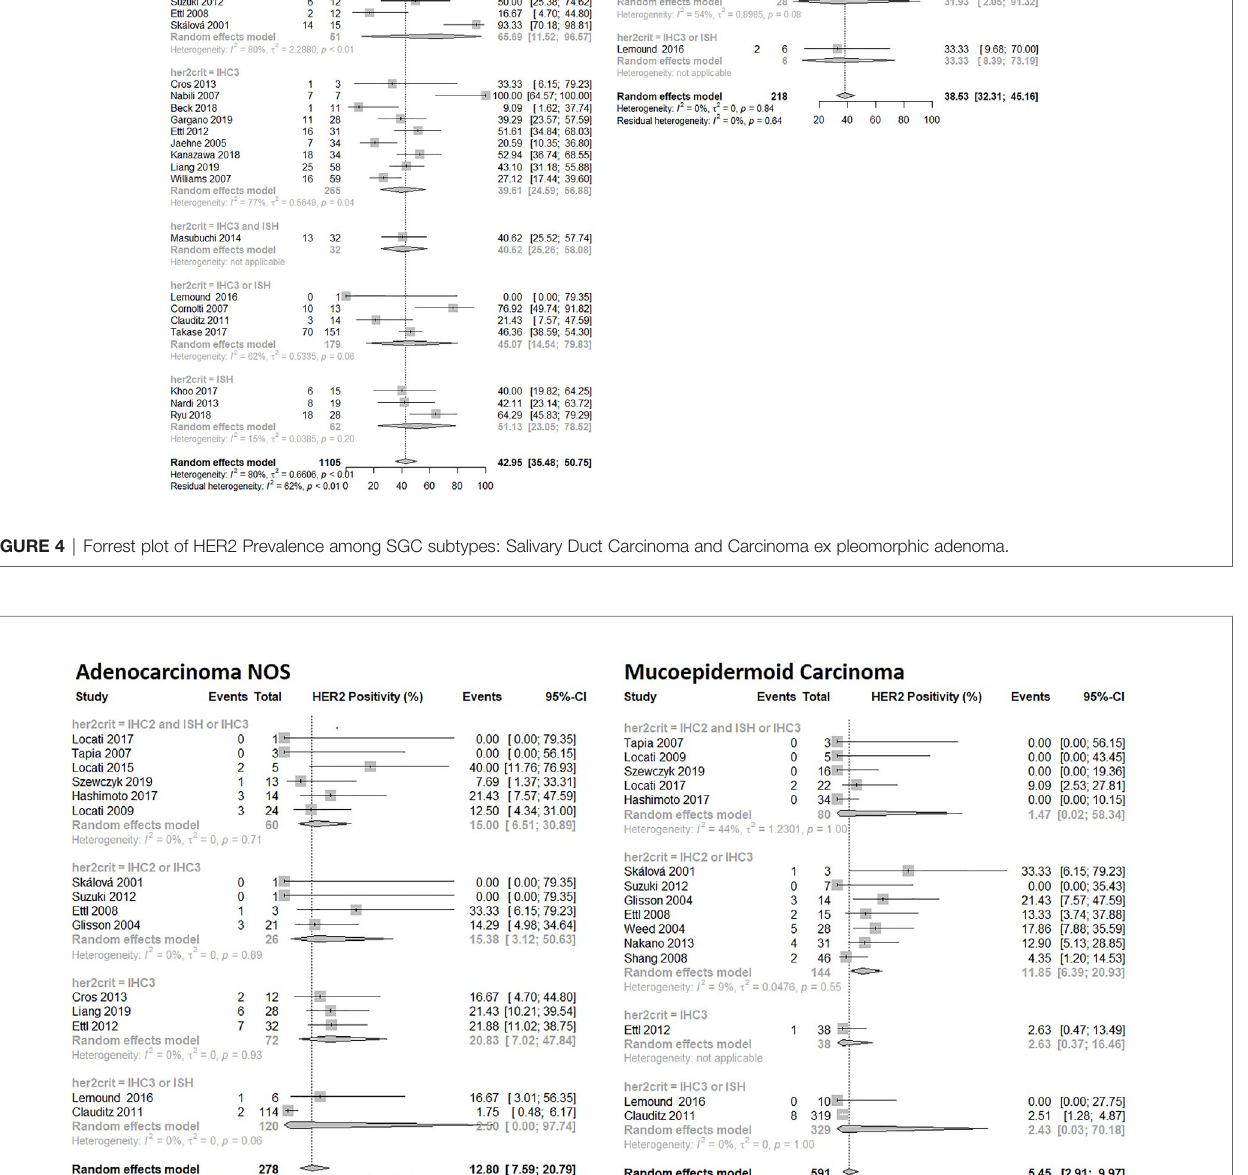
FIGURE 5 | Forrest plot of HER2 Prevalence among SGC subtypes: Adenocarcinoma NOS and Mucoepidermoid Carcinoma.